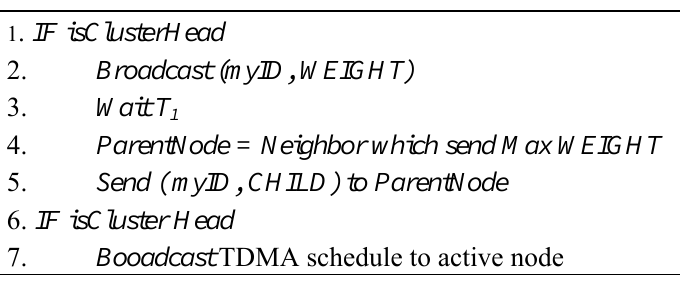
Figure 5. Routing Tree